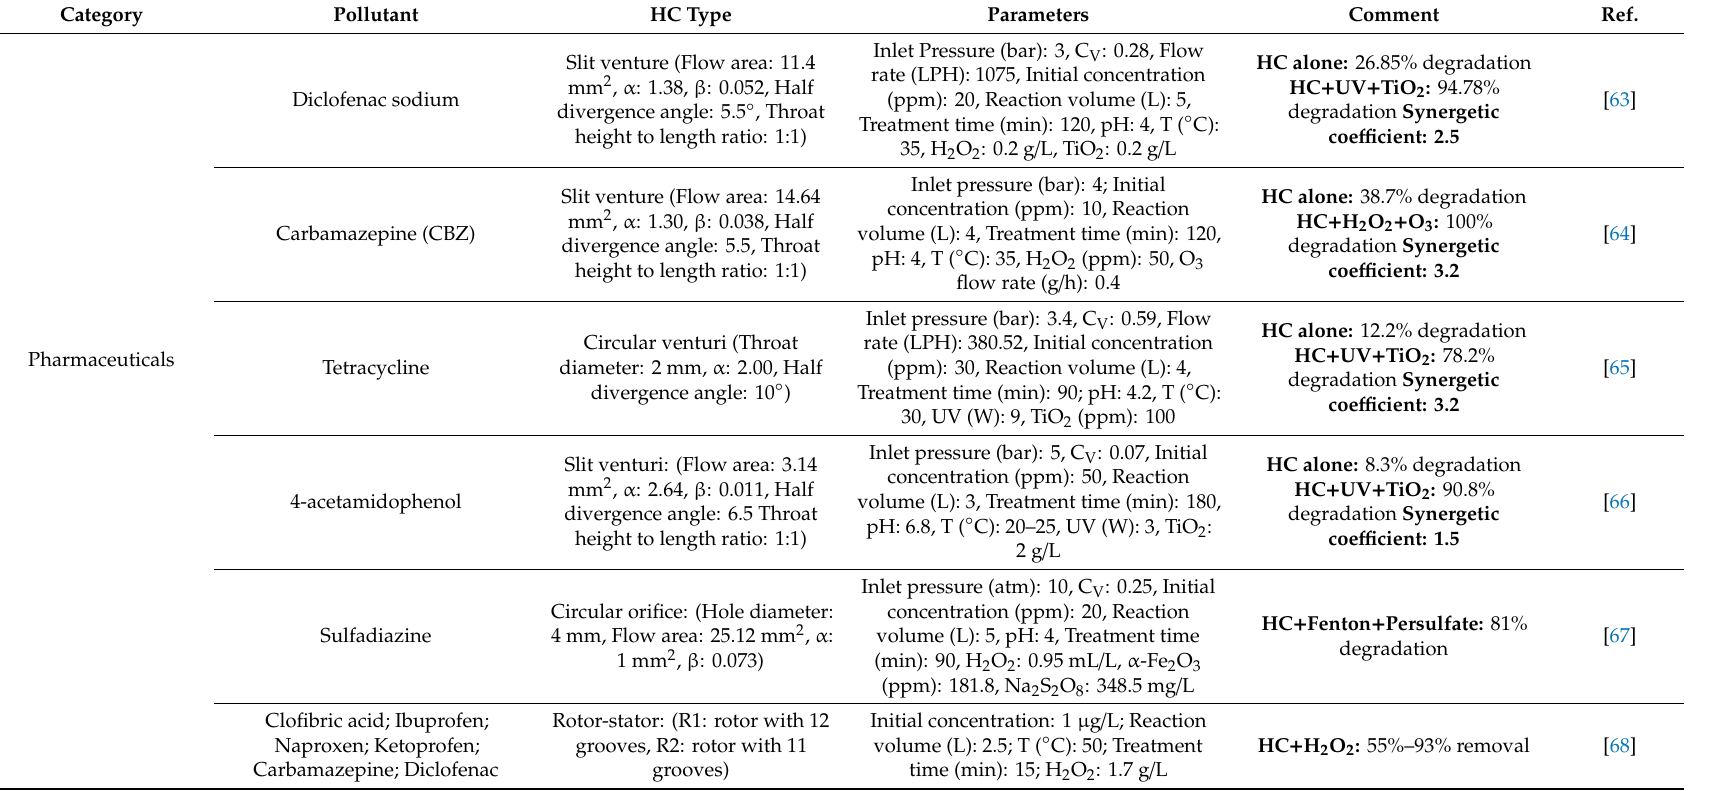
Table 5. HC-assisted remediation of toxic